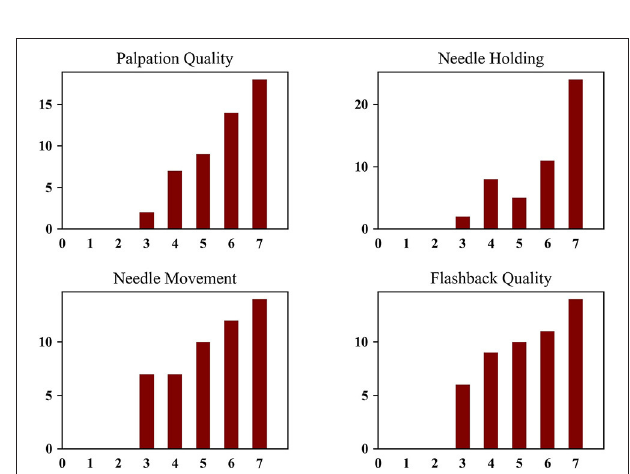
FIGURE 6 | GRS of Individual Categories (Note: inexperienced = 1, low borderline competence = 2, high borderline competence = 3, low average competence = 4, high average competence = 5, low excellent competence = 6, high excellent competence =